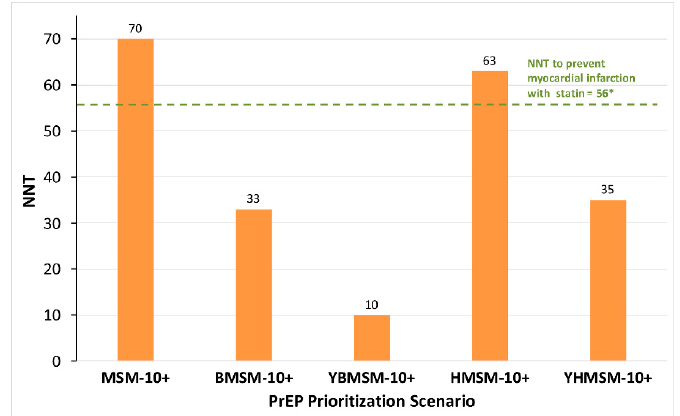
Figure 2. Number needed to treat to prevent one new HIV infection under each PrEP